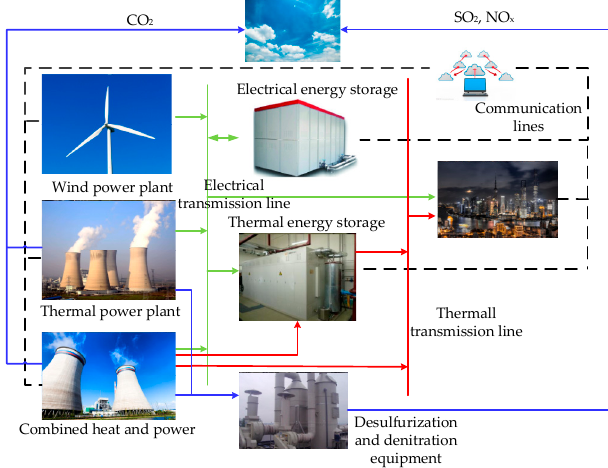
Figure 3. Structural diagram of the entire system.